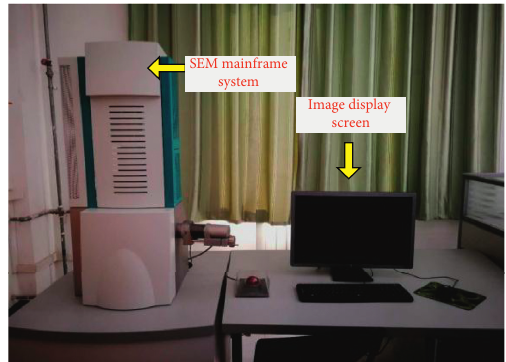
Figure 12: TESCAN VEGA scanning electron microscope